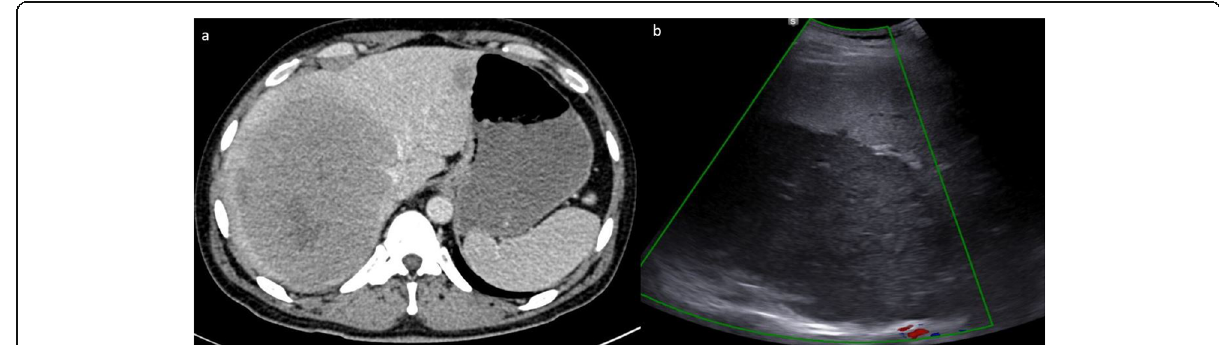
Fig. 3 Axial CT images axial contrast-enhanced CT image and liver ultrasound of a patient with HIV-associated primary hepatic lymphoma. The contrast- enhanced CT shows a homogeneous soft tissue attenuation mass which does not show significant enhancement, and with fear preservation of the surrounding liver architecture. The mass displaces or encases the hepatic veins but does not invade vasculature or lead to tumor thrombus. On ultrasound, it appears as a fairly homogenous mass hypoechoic to the liver parenchyma. There is no increase vascularity within the mass or in its periphery